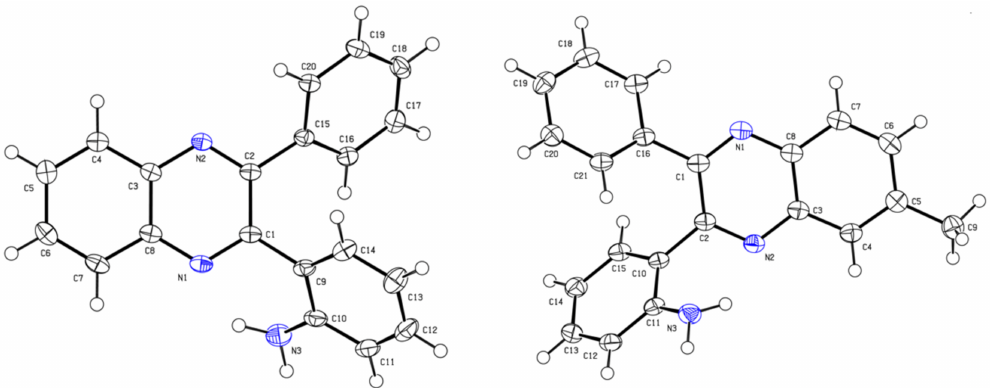
Figure 1. ORTEP drawings of X-ray structures for 2-(3-phenylquinoxalin-2-yl)aniline 4aa (left, CCDC #2195374) and 2-(7-methyl-3-phenylquinoxalin-2-yl)aniline 4 (cid:48) bb (right, CCDC #2195382). Thermal ellipsoids for non-hydrogen atoms are shown at 50% probability. Blue: nitrogen, gray: carbon